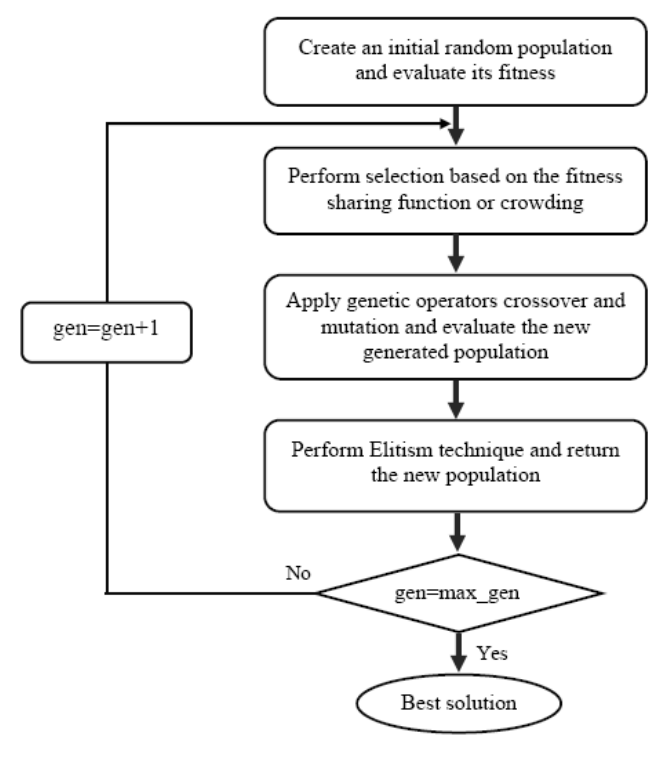
Figure 2. A proposed hybrid GA Scheme.